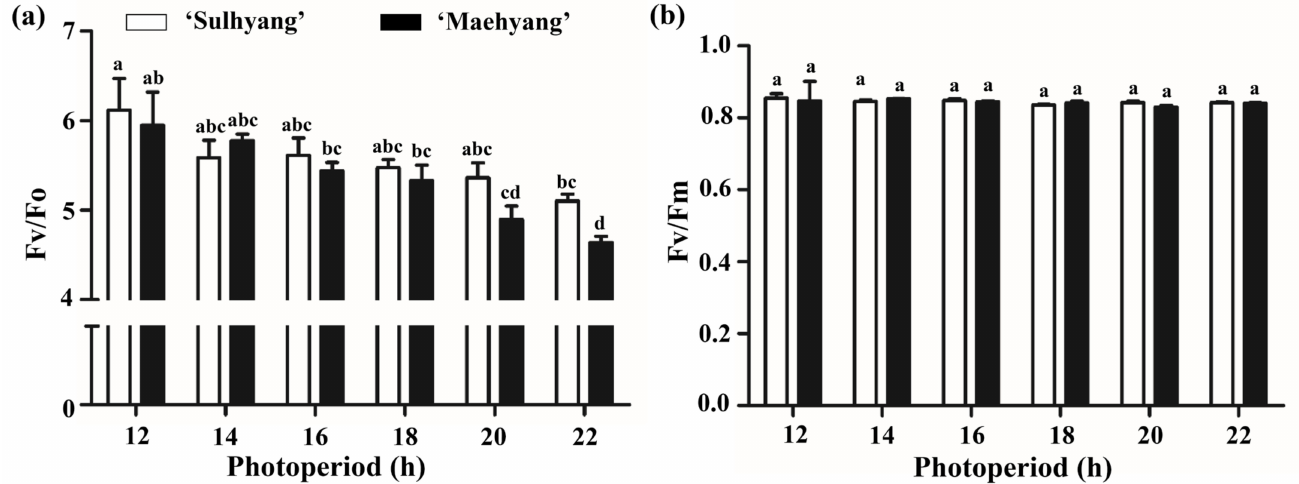
Figure 6. The Fv/Fo ( a ) and Fv/Fm ( b ) as affected by photoperiod. Lowercase letters indicate significant difference according to the Duncan’s multiple range test at a 0.05 level. Vertical bars indicate standard